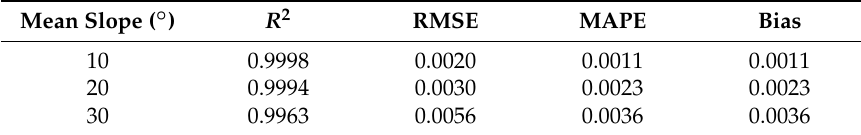
Table 4. Accuracy statistics of the modeled BSA over different real